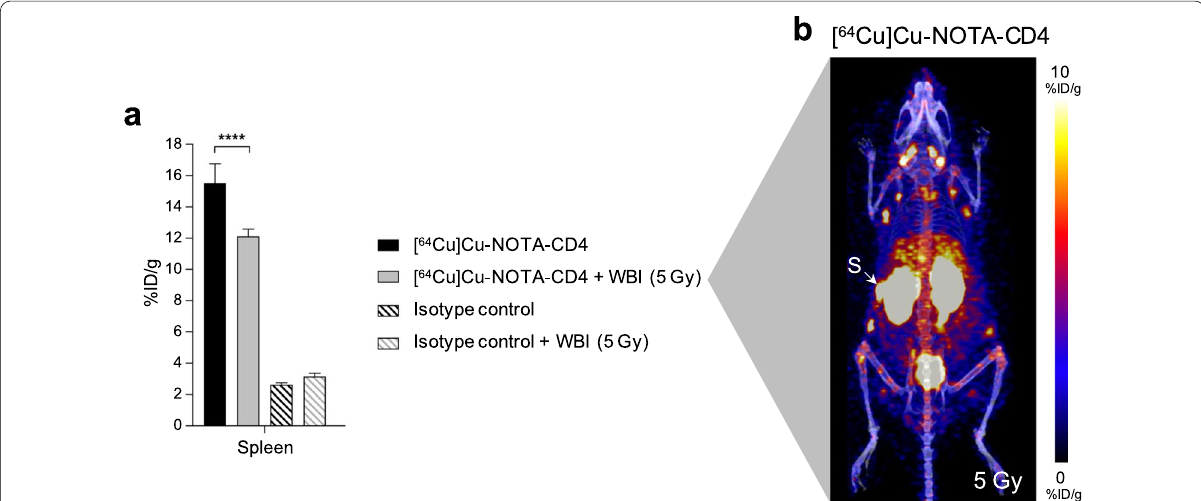
Fig. 6 [ 64 Cu]Cu-NOTA-CD4 and [ 64 Cu]Cu-NOTA-IgG2b PET imaging of C57BL/6 mice after whole-body irradiation (WBI) of 5 Gy. a [ 64 Cu] Cu-NOTA-CD4 and 64 Cu-isotype control uptake in the spleen of WBI (5 Gy) ( n as %ID/g. Images were acquired 24 h p.i. (48 h after irradiation). Spleen (S). Data are presented as mean by asterisks (*). p < 0.0001 (****). b Representative maximum intensity projection (coronal view) of a WBI mouse 24 h p.i. of [ 64 Cu]Cu-NOTA-CD4, illustrating uptake in spleen